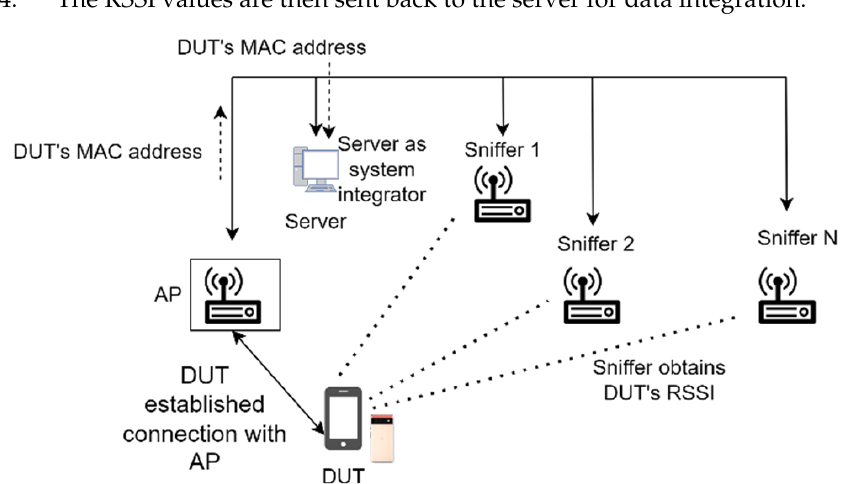
Figure 16. Extraction of DUT’s MAC address in this study.